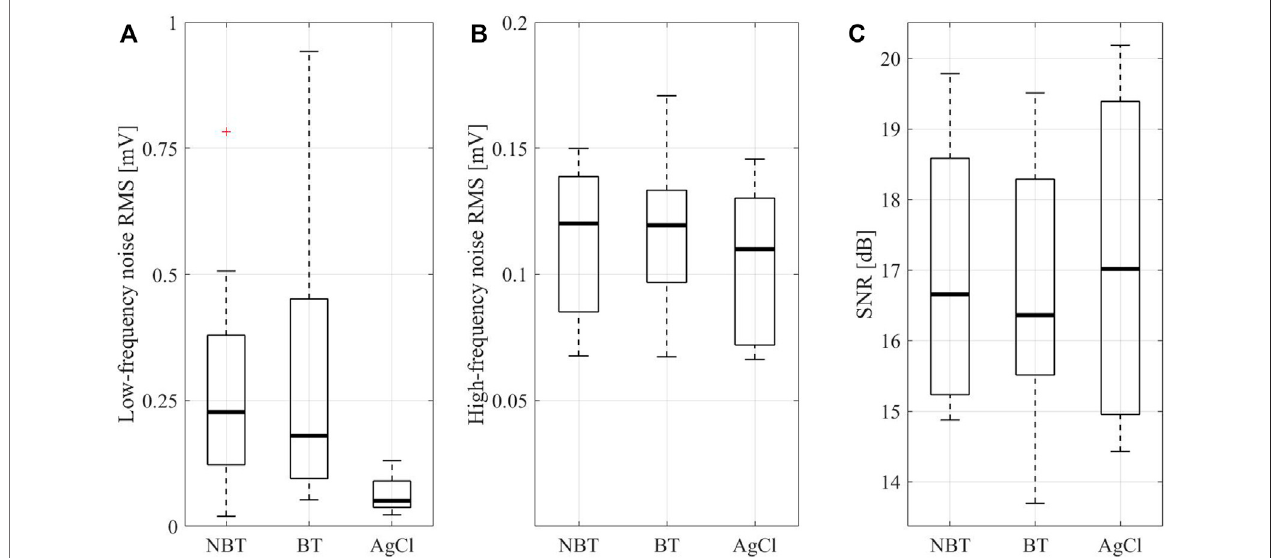
FIGURE 6 | Root-mean-square values for low-frequency (less than 0.5 Hz, (A) and high-frequency (greater than 0.5 Hz, (B) noises and the SNR values (C) characterizing the ECG recordings acquired by non-breathable tattoo (NBT), breathable tattoo (BT), and commercial gelled Ag/AgCl electrodes (AgCl). In the low- frequency noise root-mean-square representation, two outliers for non-breathable tattoo (close to 1.4 and 1.8 mV, respectively) and one for breathable tattoo (near 1.2 mV) were not represented for the sake of clarity.